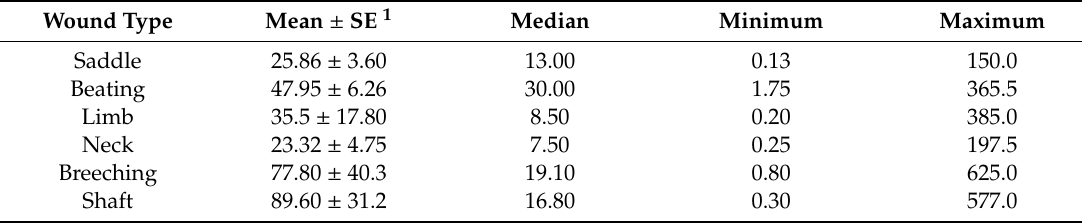
Table 4. Numerical summary of the area of di ff erent wound types (cm 2